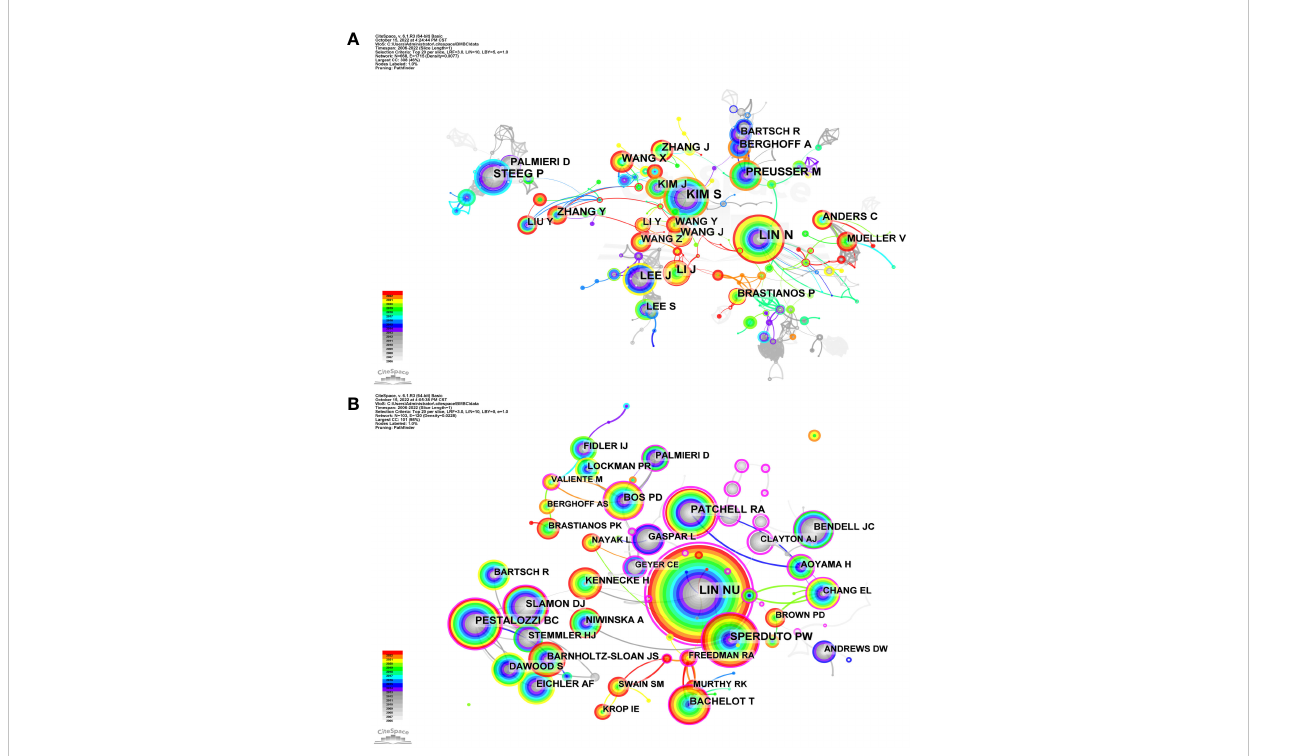
FIGURE 6 Network of authors and cocited authors on breast cancer brain metastasis. Each tree-ring node represents an author. (A) Author network based on cooccurrence analysis. The size of node is proportional to the research output of the author. The color of the tree-ring node represents